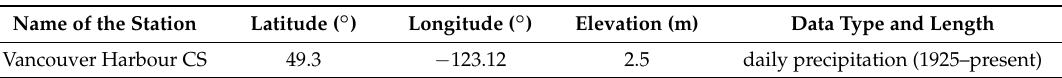
Table 1. Characteristics of the rainfall gauge station in the study